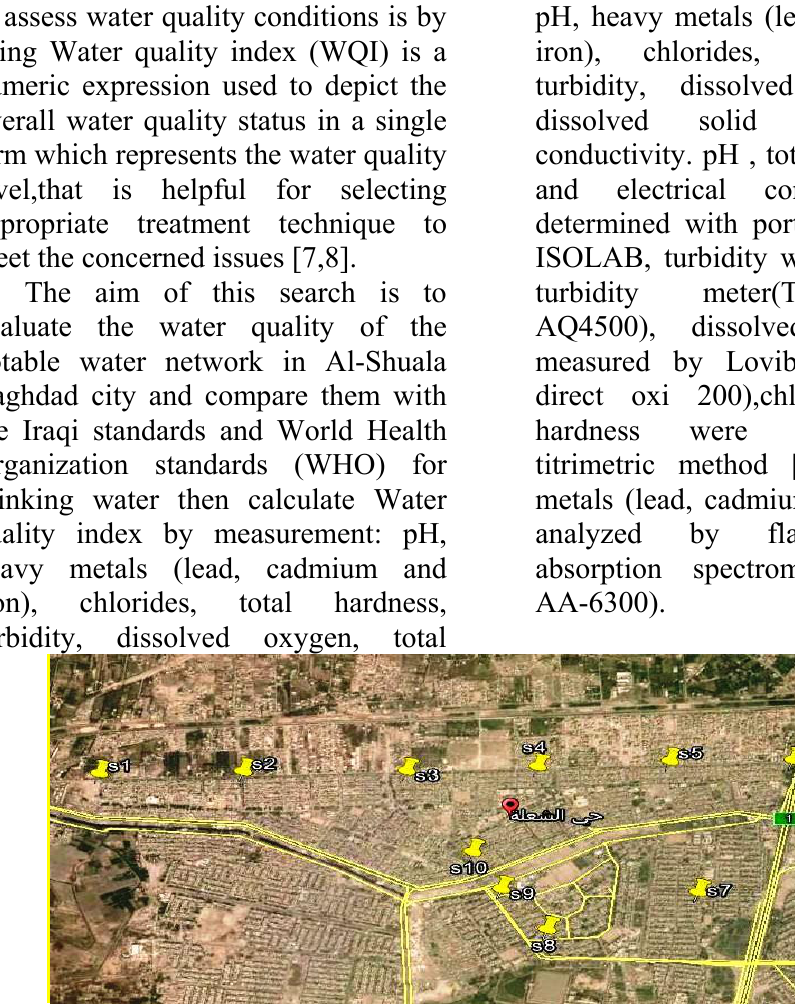
Fig. 1: Sampling sites in Al-Shuala Baghdad